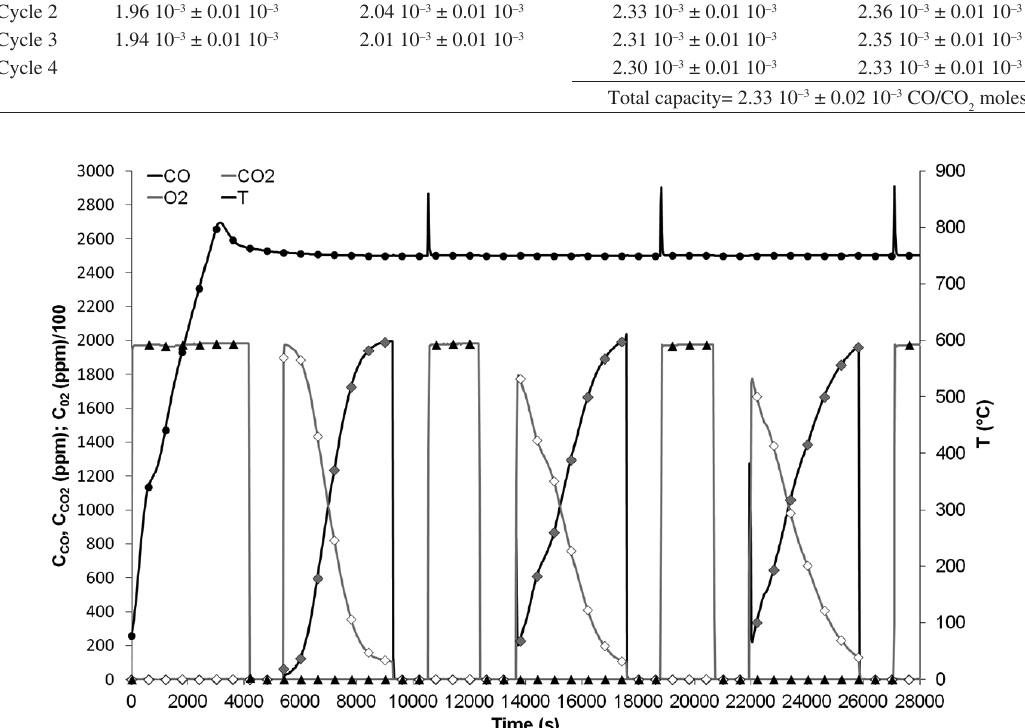
O (0.2% CO, 750 °C, 50 NL.h –1 ) according to first procedure. 2 4